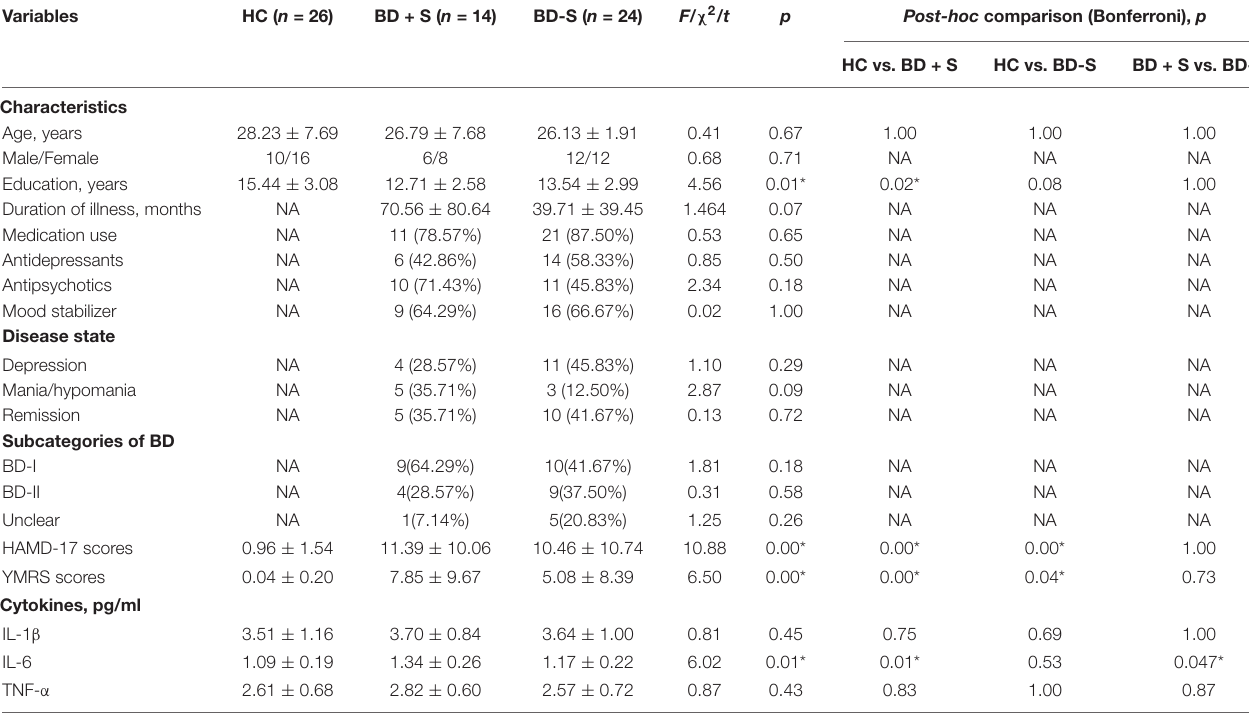
TABLE 1 | Demographic characteristics and cytokines levels of